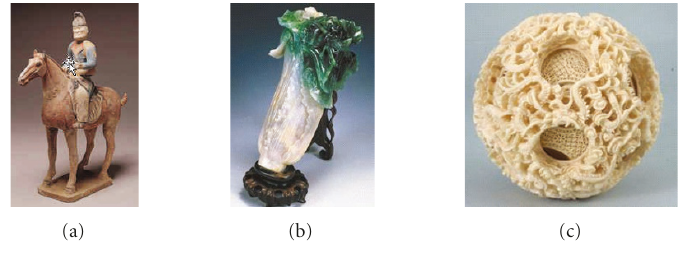
Figure 2: Some examples of museum antiques included in our object movie database.